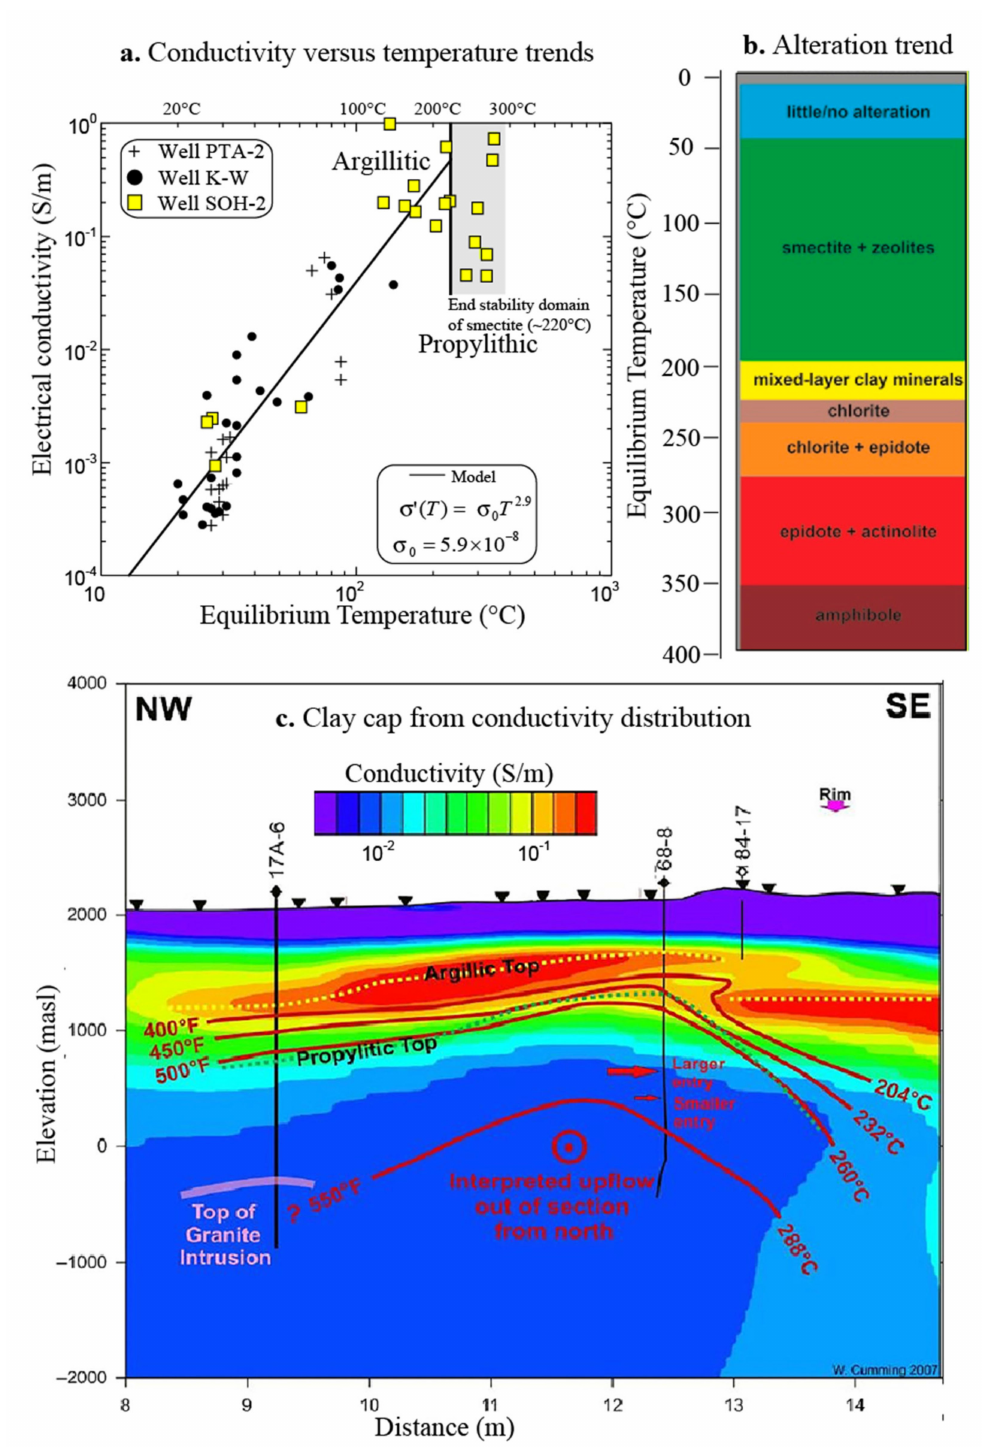
Figure 9. Conductivity, alteration, and temperature. ( a ) Temperature dependence of the electrical conductivity σ in volcanic areas using field data (samples from wells and in situ temperature measured in the same wells, see Revil et al. [52]). The electrical conductivity (measured on the core samples) is plotted versus the equilibrium temperature measured in the wells. The conductivity is corrected for the in situ temperature of the core samples in order to be used to interpret the field data. This dependence is much stronger than the dependence shown in Figure 7. ( b ) Alteration trend with the equilibrium temperature in Iceland for the secondary minerals (modified from Kousehlar et al. [79]). ( c ) Electrical conductivity distribution at Medecine lake geothermal system (USA). TGH Thermal Gradient Holes, reprinted from Cumming and Mackie